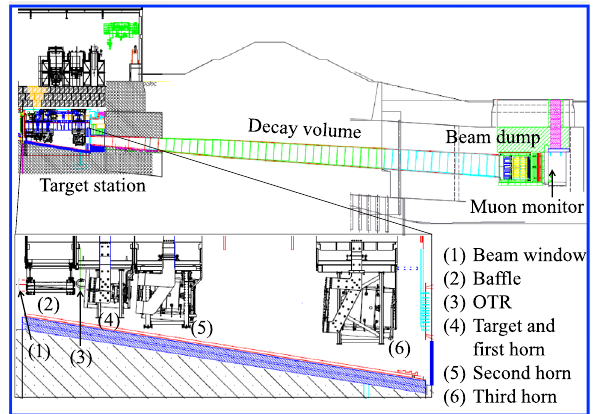
Fig. 47 Sideviewoftheneutrinobeamlinecomponentsfromthetarget to beam dump followed by the Muon Monitor. The whole volume is filled with helium gas